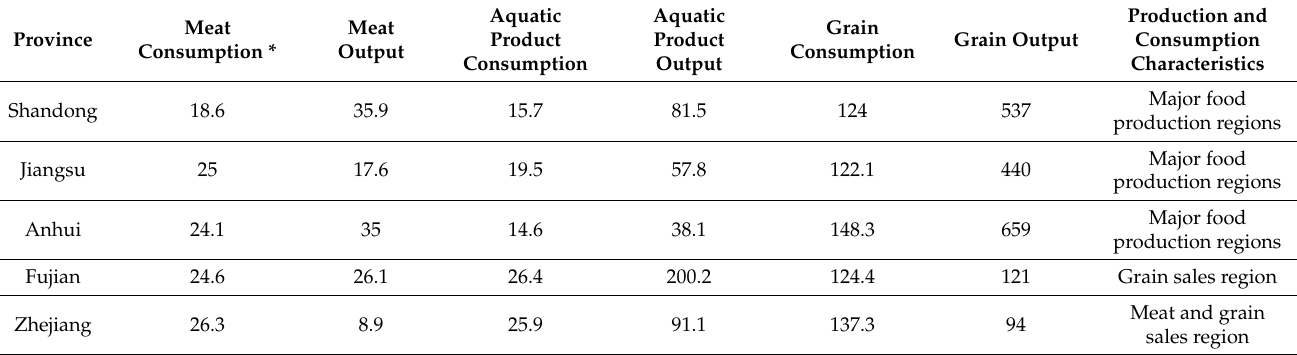
Table 1. The main food production and consumption characteristics of sample areas in